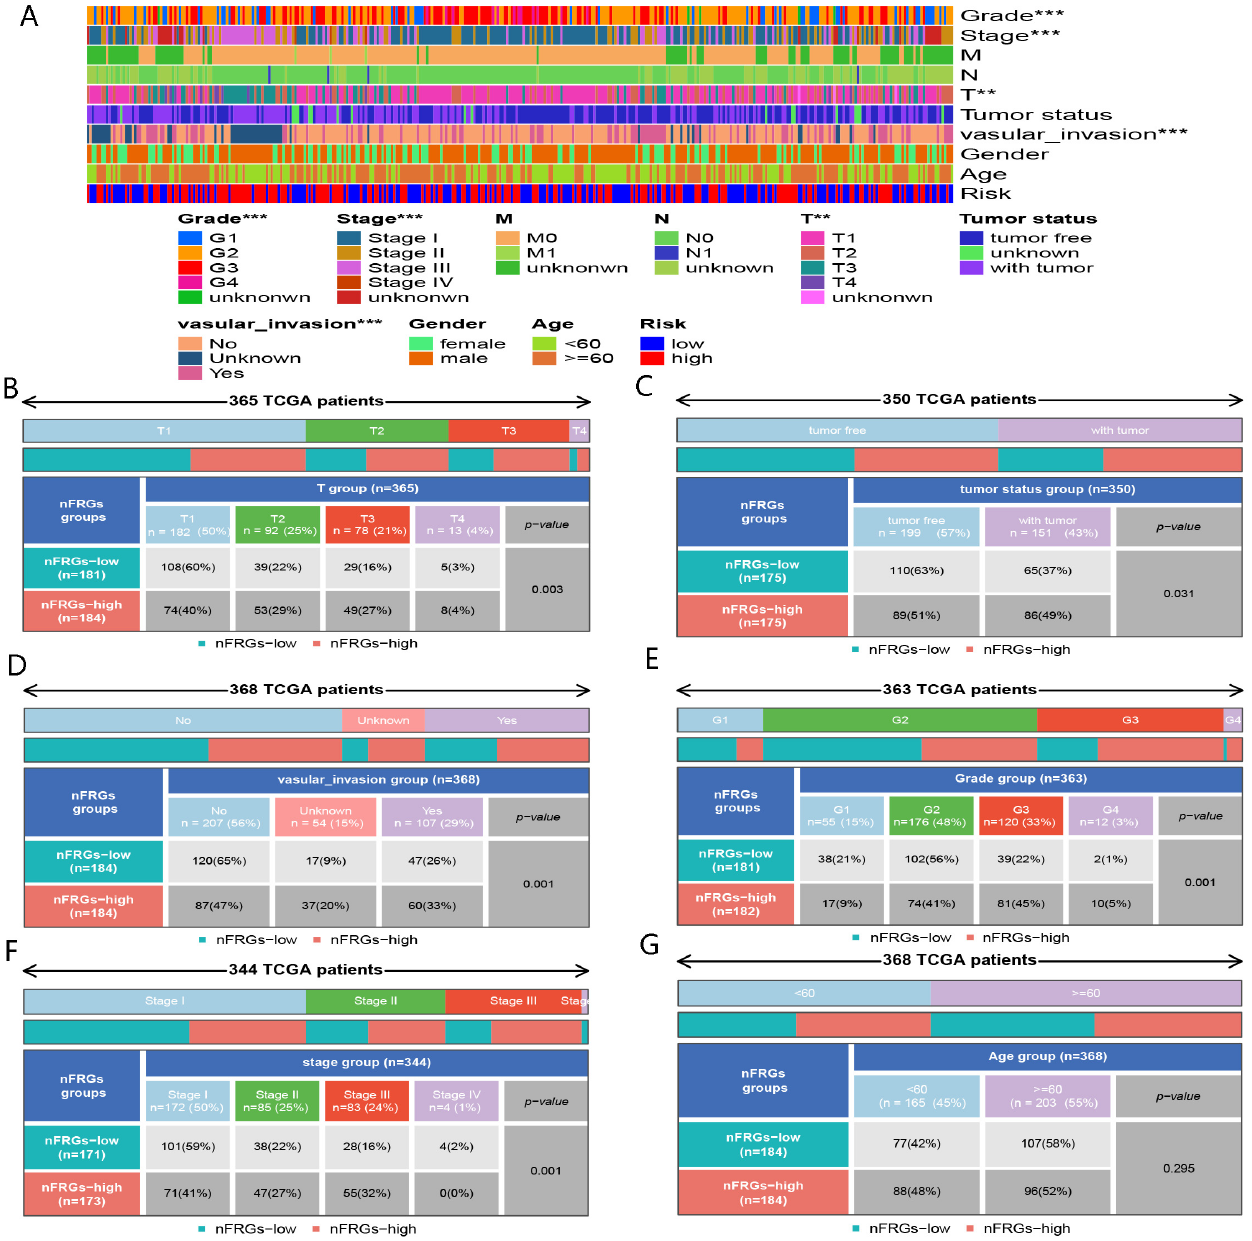
Figure 5. Correlation between nFRGs and clinical characteristics. ( A ) Correlation heat map. ( B ) Comparison of T1, T2, T3, and T4 in high- and low-risk groups. ( C ) Comparison of tumor-free and with tumor in the high- and low-risk groups. ( D ) Comparison of tumor-free and with tumor in the high- and low-risk groups. ( E ) Comparison of vascular invasion in the high- and low-risk groups. ( F ) Comparison of G1, G2, G3, and G4 in the high- and low-risk groups. ( G ) Comparison of stage I, and stage II, as well as stage III, and stage IV in the high- and low-risk groups. (**, *** representing p < 0.01 and p < 0.001, respectively).